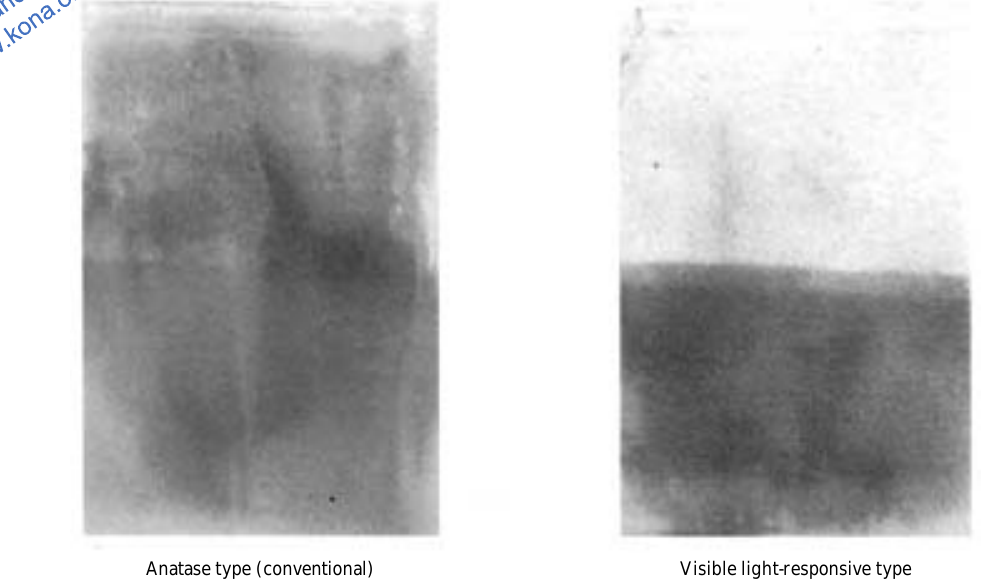
lamp)Anatase type (conventional) Visible light-responsive